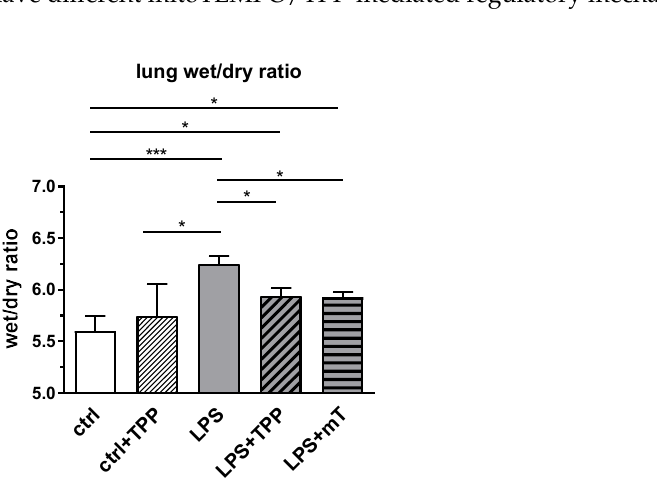
Figure 5. Effect of lipopolysaccharide (LPS, 1.75 mg/kg), methyltriphenylphosphonium chloride (TPP, 50 nmol/kg) and mitoTEMPO (mT, 50 nmol/kg) on the wet/dry ratio in rat lung. Treatment with lipopolysaccharide (LPS) elevated the wet/dry ratio whereas both TPP and mitoTEMPO reduced the wet/dry ratio to a similar extent. One-way analysis of variance (ANOVA), Fisher’s least significant difference (LSD), n = 3-8, mean ± SEM, * p < 0.05, *** p < 0.001.